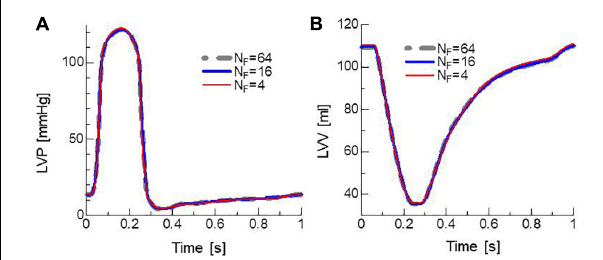
FIGURE 5 | Time transients of (A) left ventricular pressure (LVP) and (B) volume (LVV) for N F = 4 (thin red lines), 16 (medium thick blue lines), and 64 (thick gray broken lines). (cid:49) T = 1.25 ms and (cid:49) t = 5 µ s were applied. These almost equal time transients were taken from the third cycle after the initial process of blood